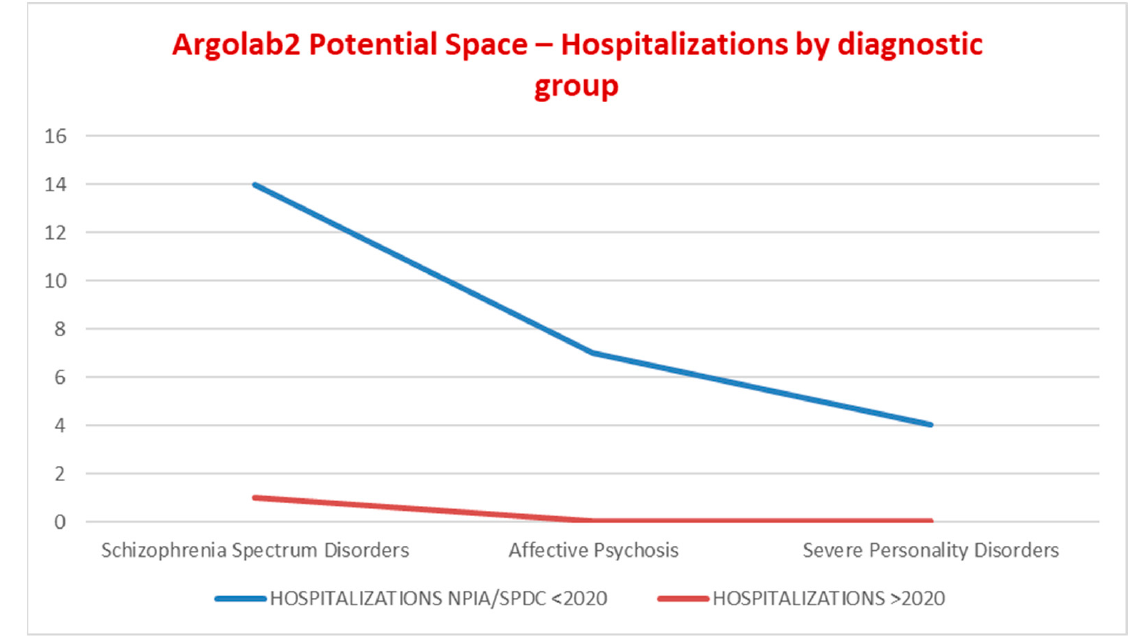
Figure 5. “Argolab2 Potential Space” —Hospitalizations by diagnostic group.